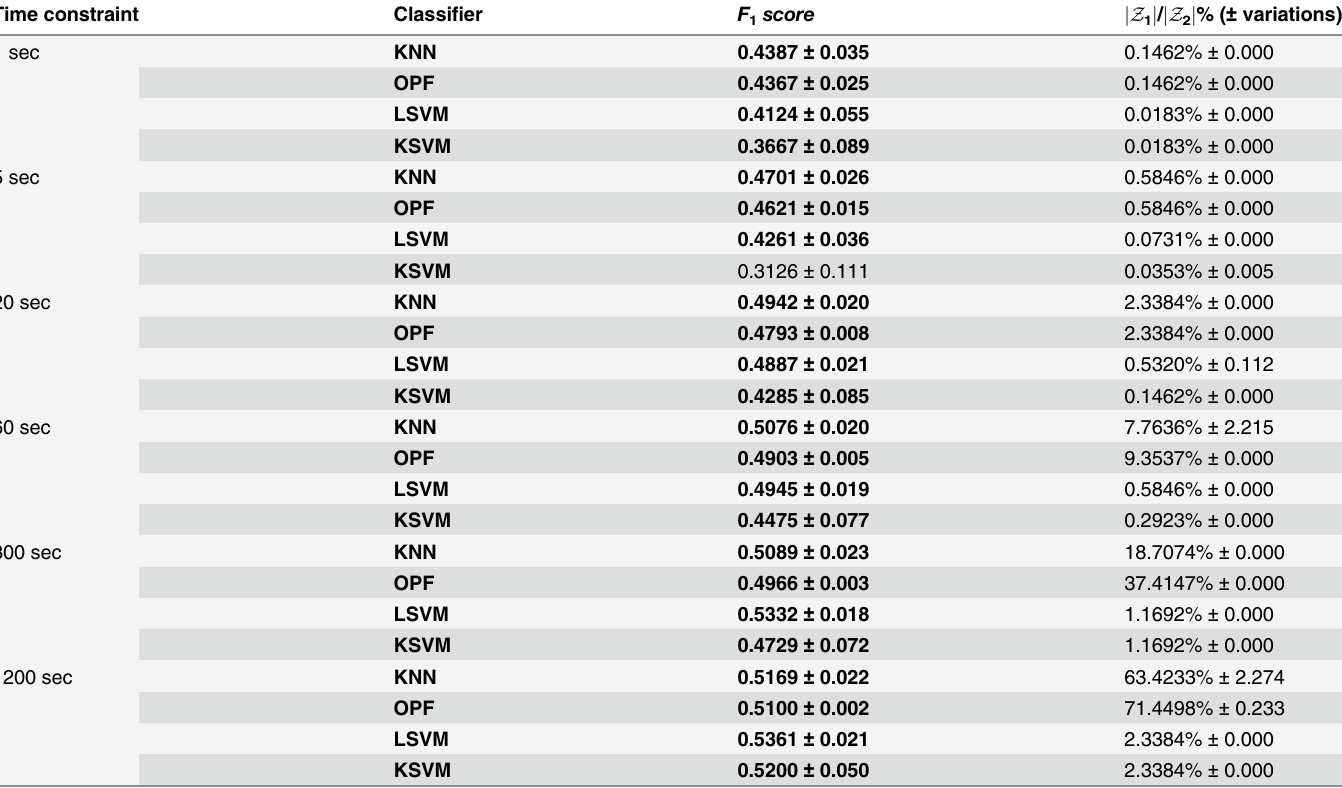
Table 6. SensIT dataset: Predictivity performance over Z 3 and final training set size, j Z 1 j as a percentual of j Z 2 j , for each classification model and learning time constraint using the proposed selection.